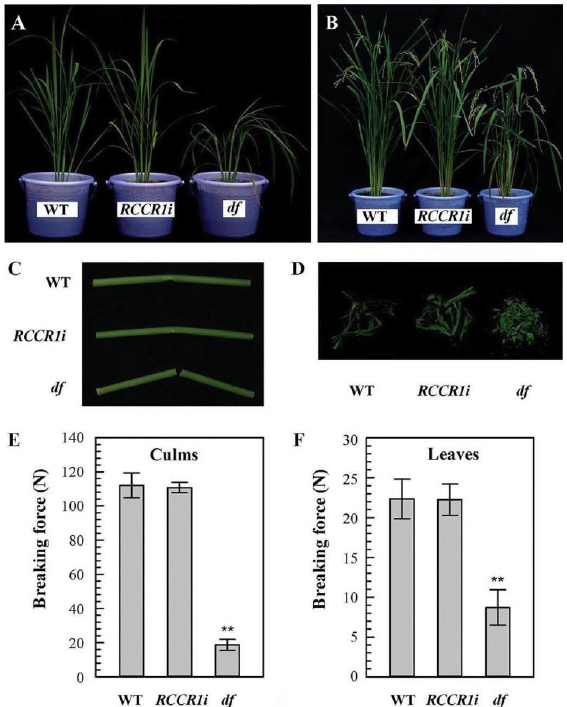
Figure 1. The phenotypes of df plants. ( A ) Tillering stage plants. ( B ) Filling stage plants. Brittleness of culms ( C ) and leaves ( D ). Breaking force for culms ( E ) and leaves ( F ). The second internode and flag leaves of filling stage plants were used for the test. When testing the culm, the leaf sheath was included. Error bar indicates ± SD from at least four biological repeats. ** Indicates significant difference ( p < 0.01) between the df (drooping and fragile) mutant and RCCR1i plants.